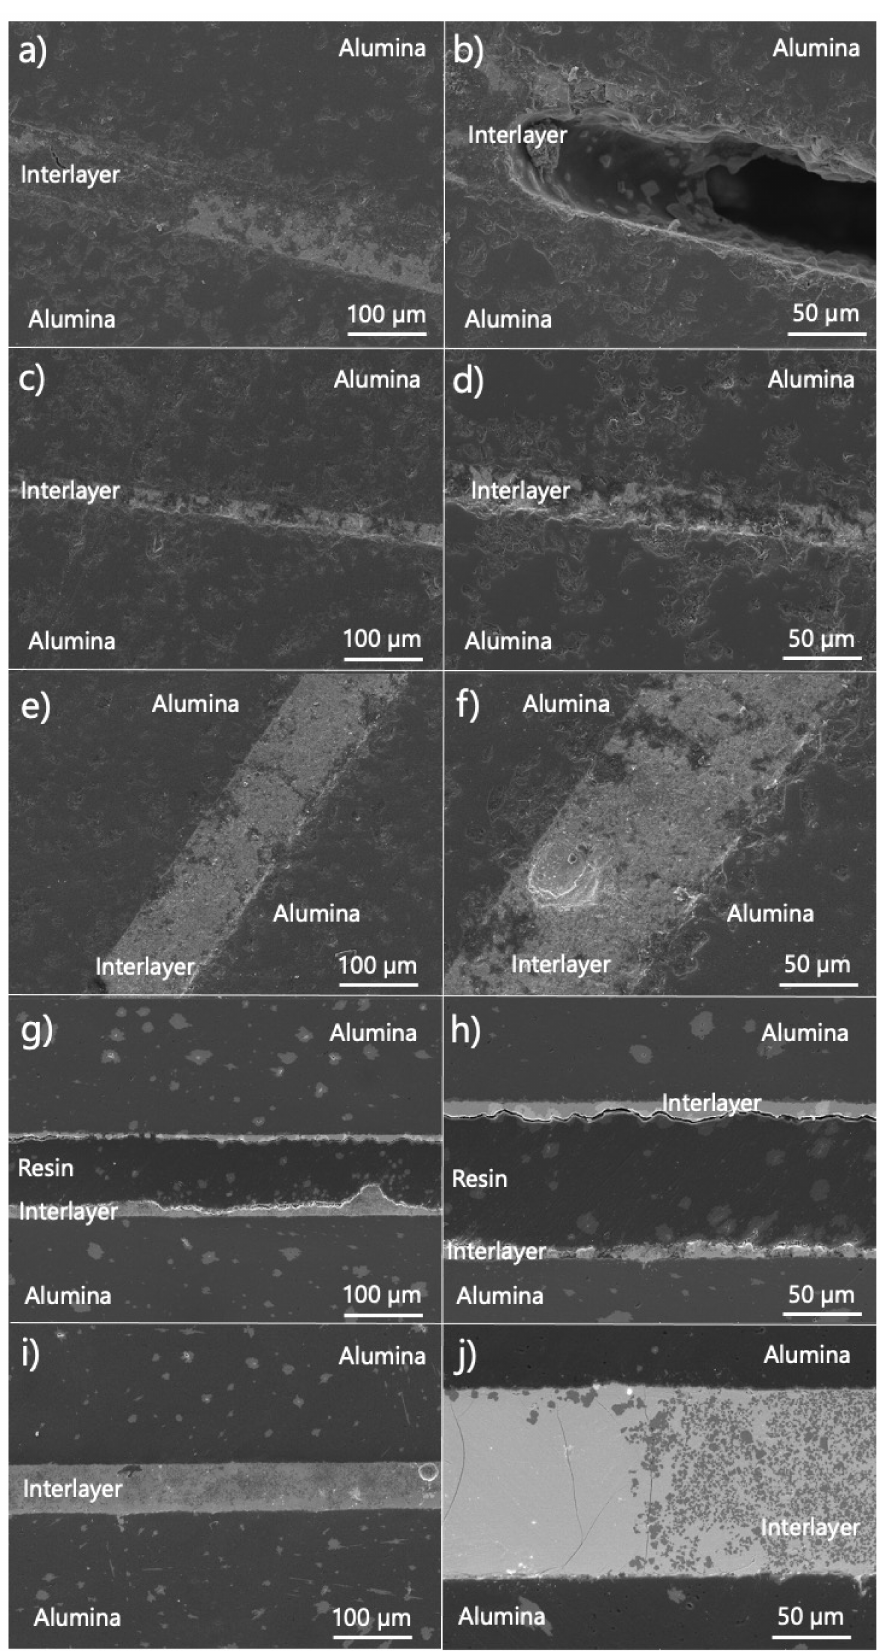
Figure 2. SEM cross-section images of obtained joints after thermal treatment at 750 ◦ C with the different compositions of the interlayers: ( a , b ) Bi 2 O 3 -5% of ZnO, ( c , d ) Bi 2 O 3 -10% of ZnO, ( e , f ) Bi 2 O 3 -15% of ZnO, ( g , h ) Bi 2 O 3 -20% of ZnO and ( i , j ) Bi 2 O 3 -25% of